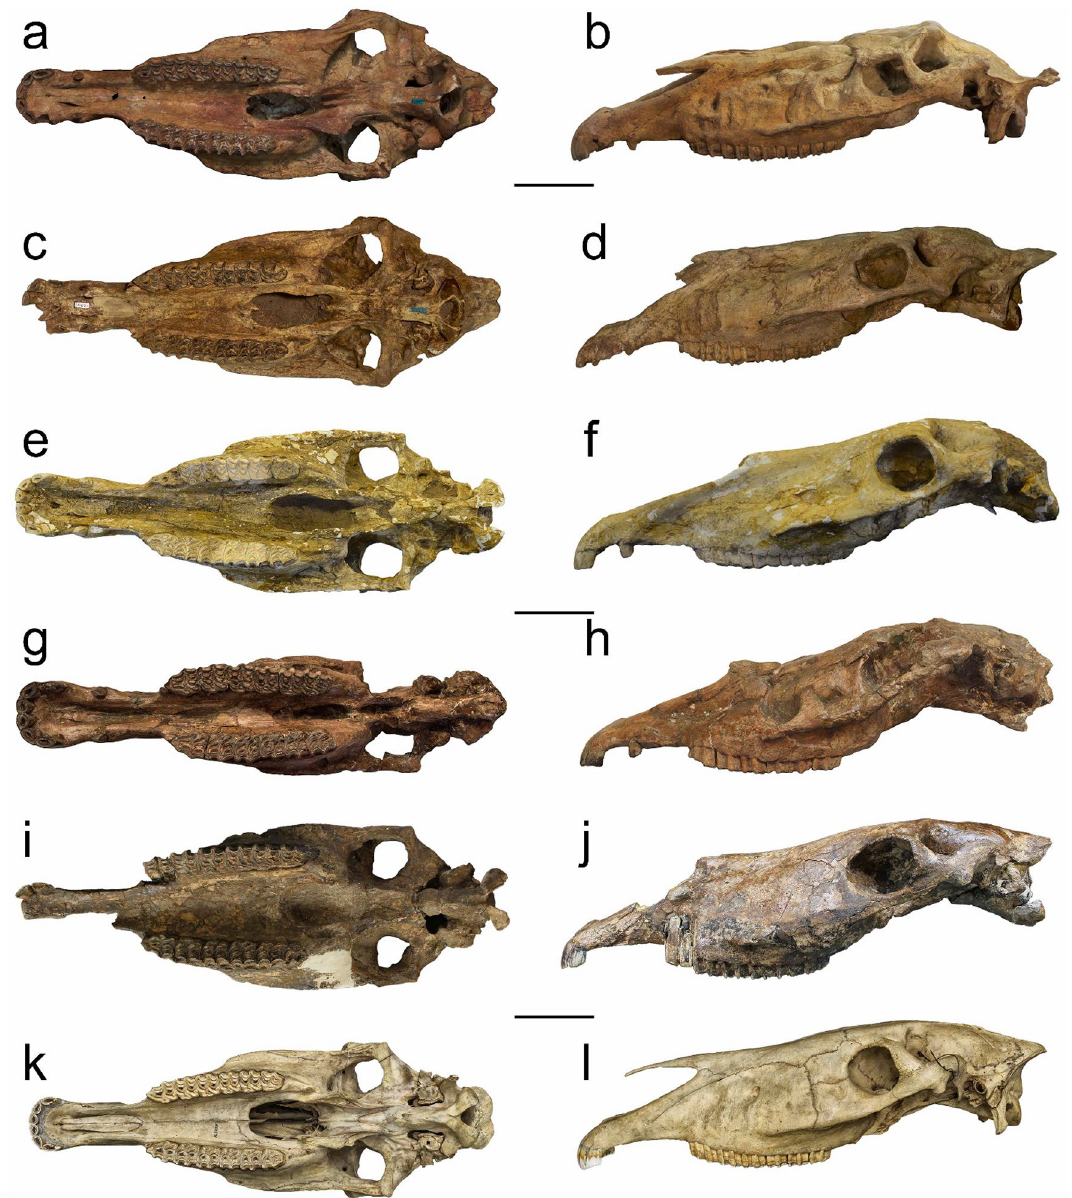
Figure 4. Comparisons of skulls, ventral and lateral views: E. simplicidens (USNM12573 and USNM12542, ( a – d ), E. stenonis (NHML20.163360 and IGF560 ( e – h ), E. koobiforensis (KNM-ER1284, i-j) and E. grevyi (USNM163228 k-l). Scale bar 10